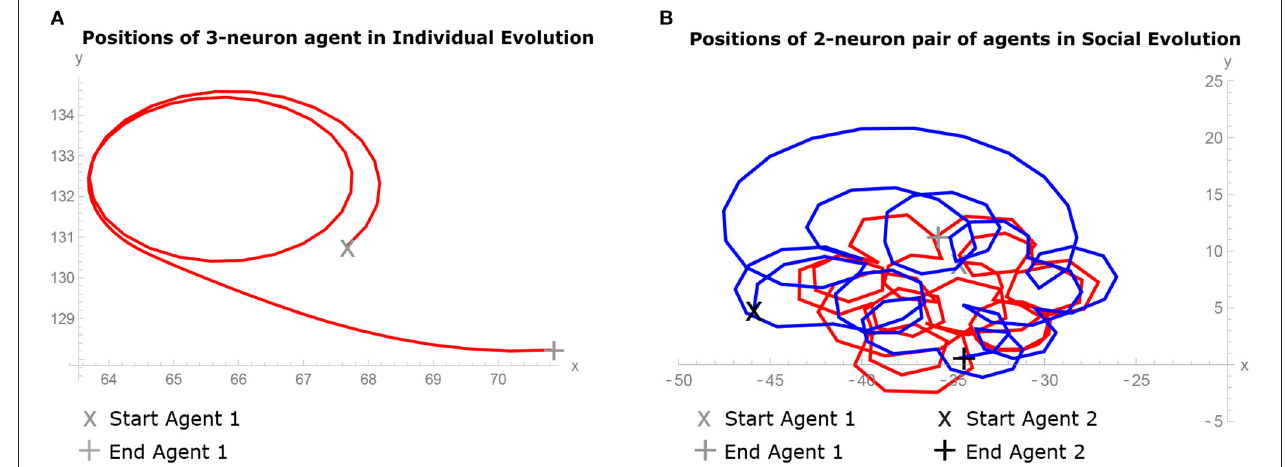
FIGURE 2 | Behavior of agents during the last 10 simulation seconds of the trial. (A) Trajectory of the best 3-neuron agent evolved in Individual Evolution (IE) condition from the best run, showing simple loops movement. (B) Trajectories of the best pair of 2-neuron agents evolved in Social Evolution (SE) condition from the best run, showing spiralling nested pairwise loops movement.